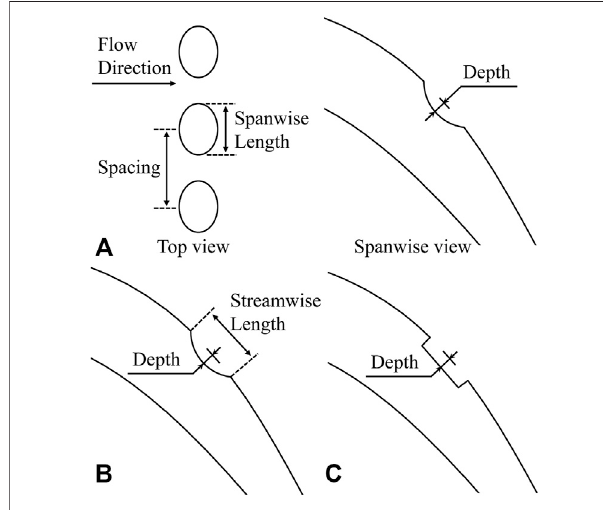
FIGURE 1 | Dimple and groove geometry: (A) dimple; (B) U-groove; (C) rectangular groove.